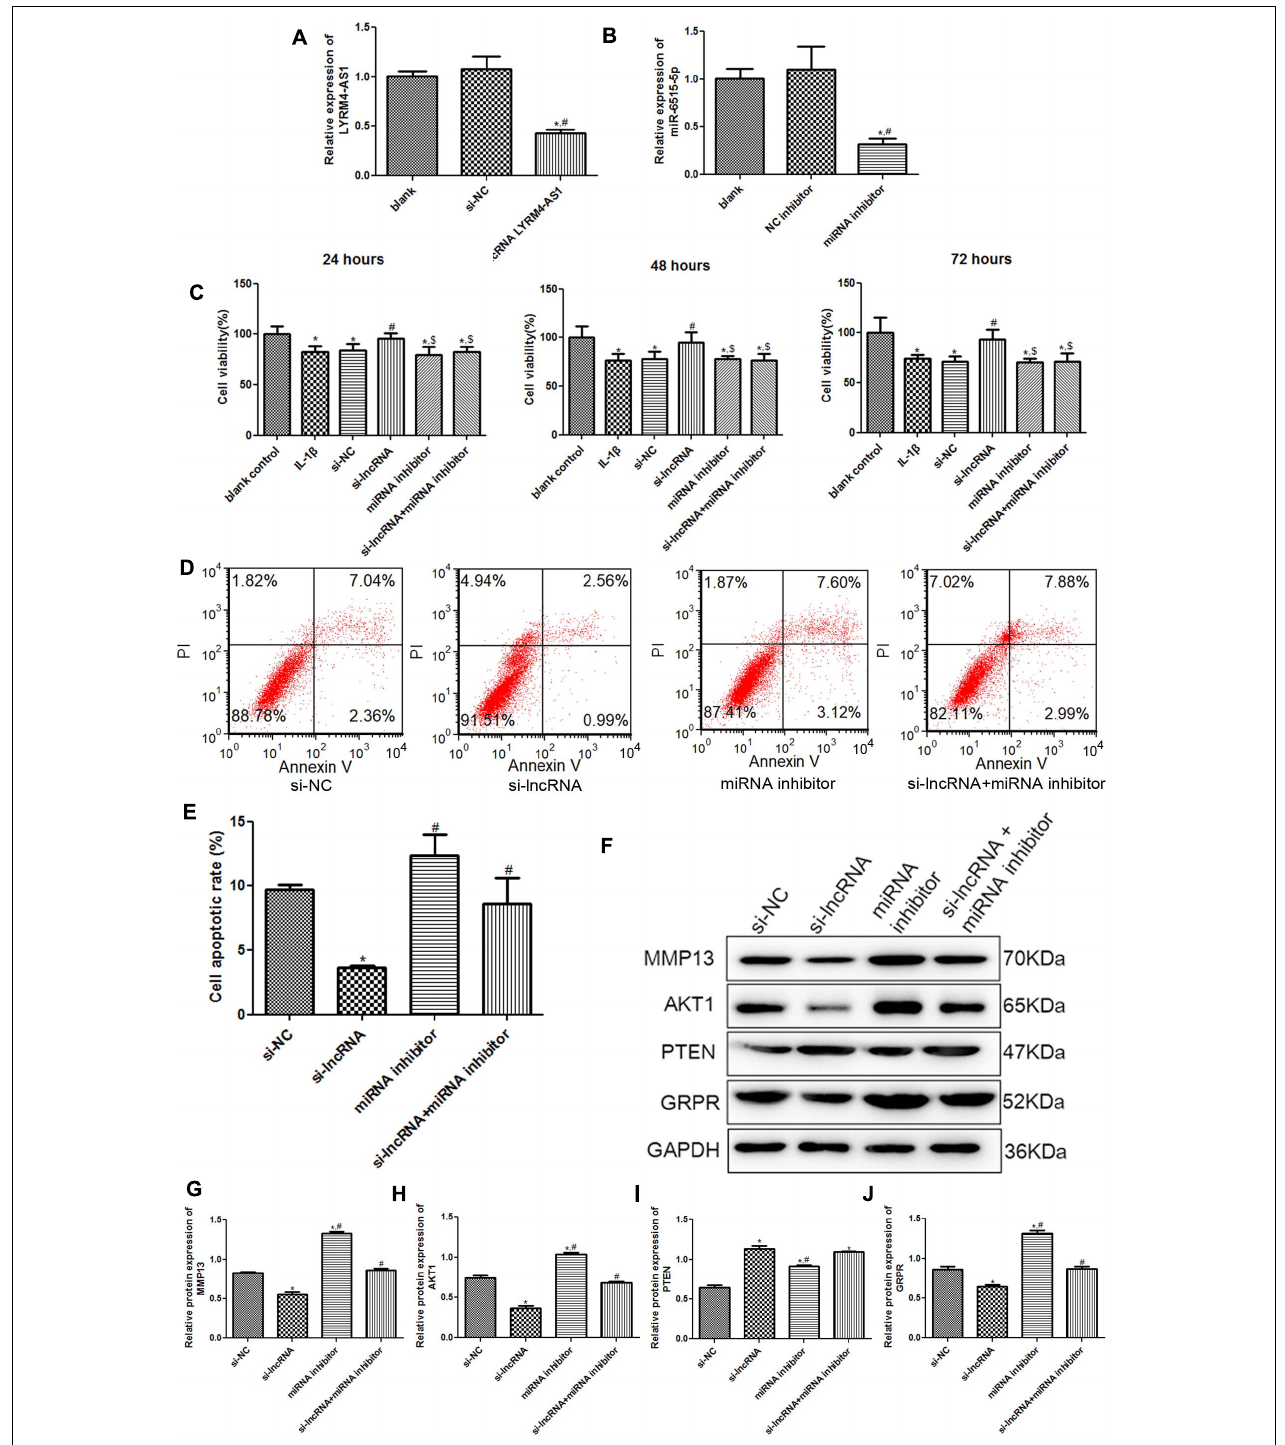
FIGURE 6 | (A) The relative expression of lncRNA LYRM4-AS1 after transfection. n = 3. * P < 0.05 vs. blank group; # P < 0.05 vs. si-NC group. (B) The relative expression of miR-6515-5p after transfection. n = 3. * P < 0.05 vs. blank group; # P < 0.05 vs. NC inhibitor group. (C) After cell transfection, the cell viability of chondrocytes was examined using CCK-8 assay. n = 3. * P < 0.05 vs. blank control group; # P < 0.05 vs. IL-1 β group. $ P < 0.05 vs. si-lncRNA LYRM4-AS1 group. (D) The images of cell apoptosis acquired by flow cytometry. (E) The cell apoptosis rate of chondrocytes after transfection analyzed by CellQuest software. n = 3. * P < 0.05 vs. si-NC group; # P < 0.05 vs. si-lncRNA LYRM4-AS1 group. (F) The protein bands of MMP13, AKT1, PTEN, and GRPR detected by western blot. The relative protein expression of MMP13 (G) , AKT1 (H) , PTEN (I) , and GRPR (J) in different groups. n = 3. * P < 0.05 vs. si-NC group; # P < 0.05 vs. si-lncRNA group.